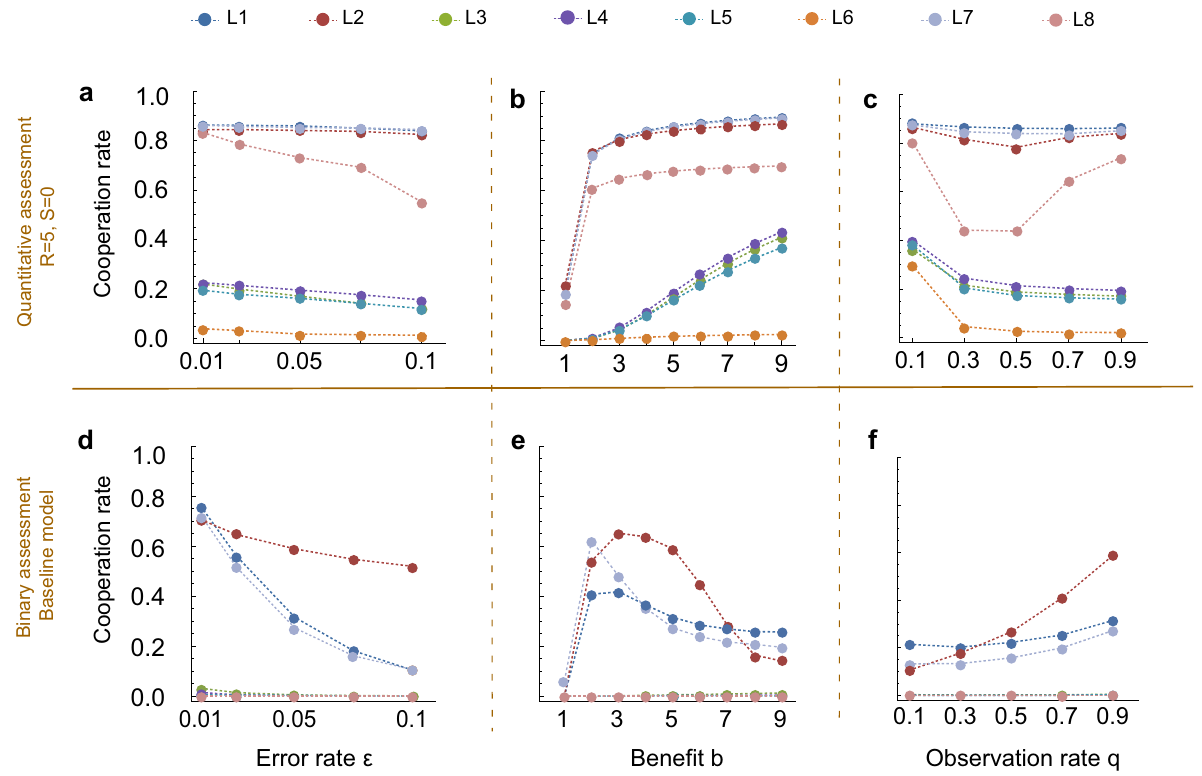
Fig.7|Quantitativeassessmenthasapositiveimpactoncooperationrates. We vary the noise on observations ε , the bene fi t-to-cost ratio b / c , with c =1, and observation probability q . All other parameters remain constant at the values of Fig. 5. In each scenario, we plot the average cooperation rate of each individual leading eight norm when they compete against ALLD and ALLC, according to the selection – mutation equilibrium of the evolutionary process. We can compare the results when players use re fi ned assessment with R =5 ( a – c ) with the outcome of the binary assessment in the baseline model 44 ( d – f ). a Under quantitative